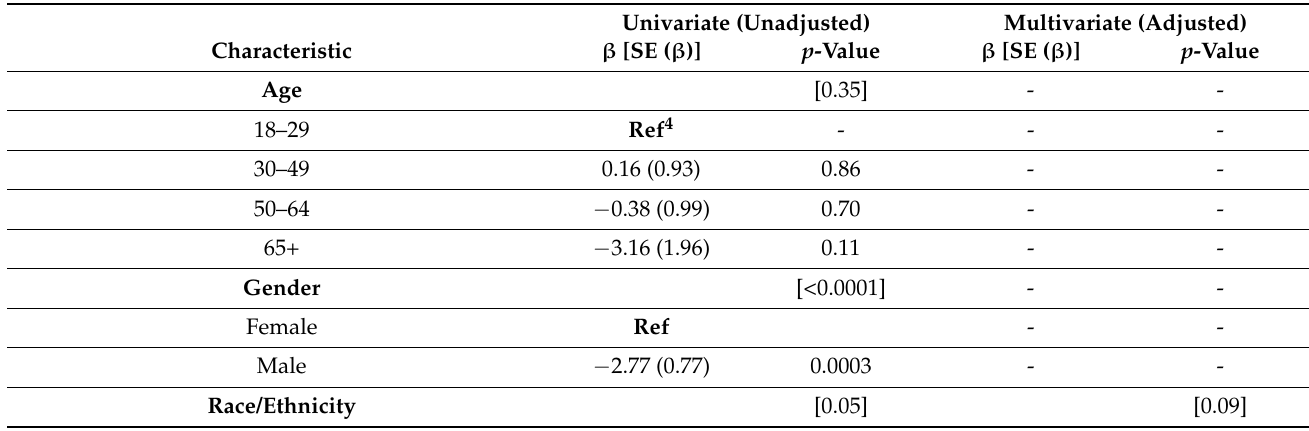
Table 2. Univariate and multivariate associations ( β [SE ( β )]; p -value) between potential predictors of the vaccine hesitancy scale from general linear regression